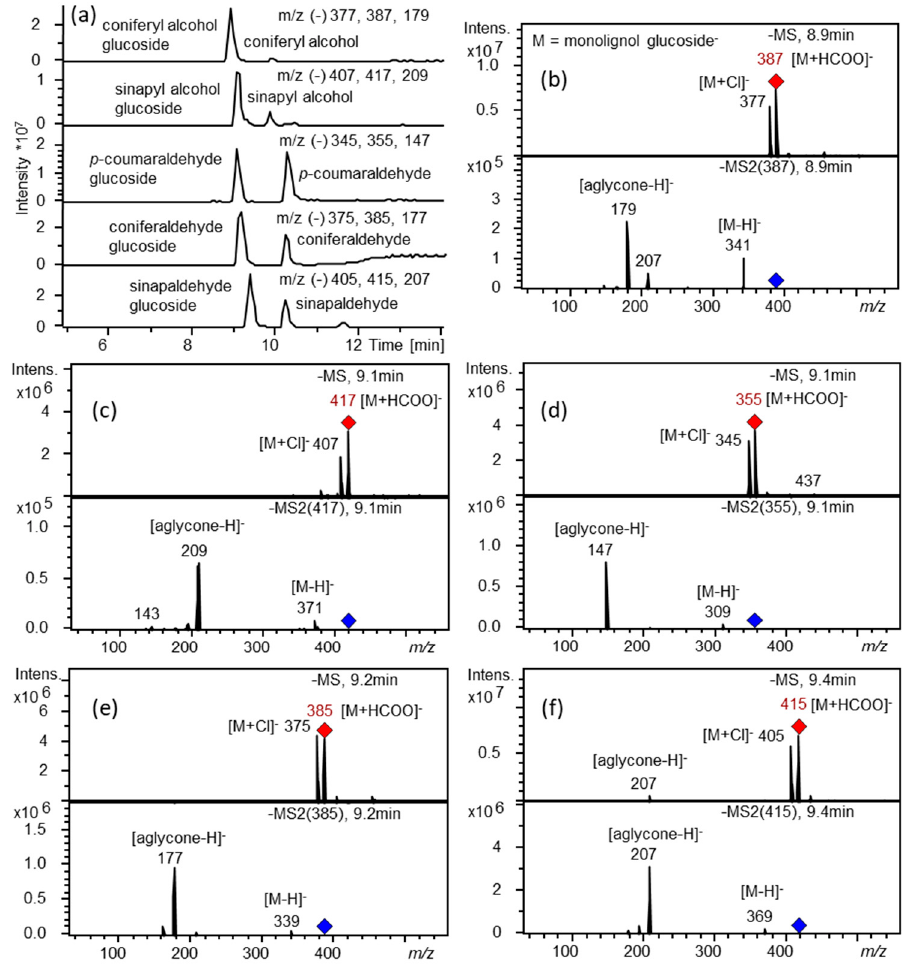
Figure 3. LC-MS analysis of UGT72B37 enzymatic reaction products. Extracted ion chromatograms ( a ), mass spectra (MS in red) and product ion spectra (MS2 in blue) of compounds formed by UGT72B37 with coniferyl alcohol ( b ), sinapyl alcohol ( c ), p -coumaraldehyde ( d ), coniferaldehyde ( e ), and sinapaldehyde ( f ) as substrates. UDP-glucose was used as sugar donor. M, monolignol